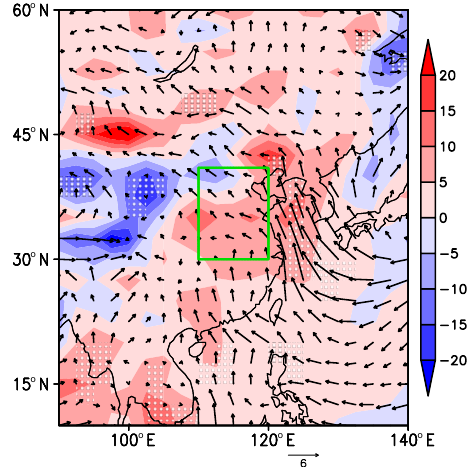
Figure 10. (a) The correlation coefficients (shading) between the preceding autumn SST and DHD NH , and the anomalous SSTs in 2016 (contour) that are calculated with respect to the period from 1979 to 2016, and (b) the correlation coefficients between SST EP and Z500 exceeding the 90% confidence level (shading), correlated WAF (arrow), and quasi-geostrophic stream function (contour) at 500hPa in